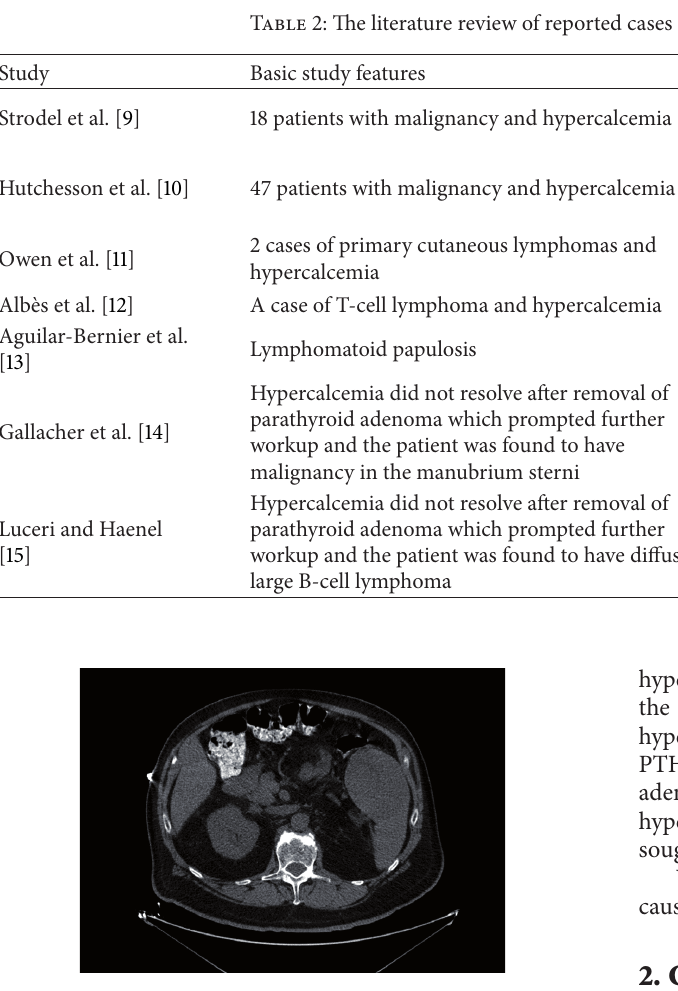
Figure 1: Abdominal CT showing splenic